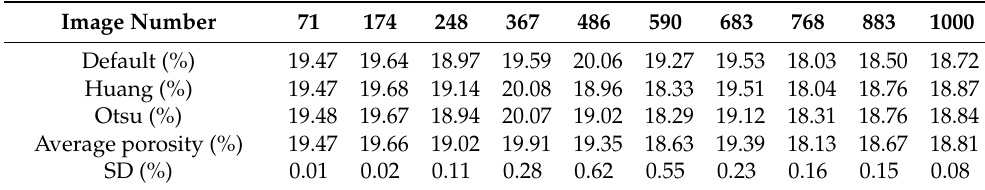
Table 3. Calculated porosities of the segmented images based on three different thresholding methods (Default, Huang, and